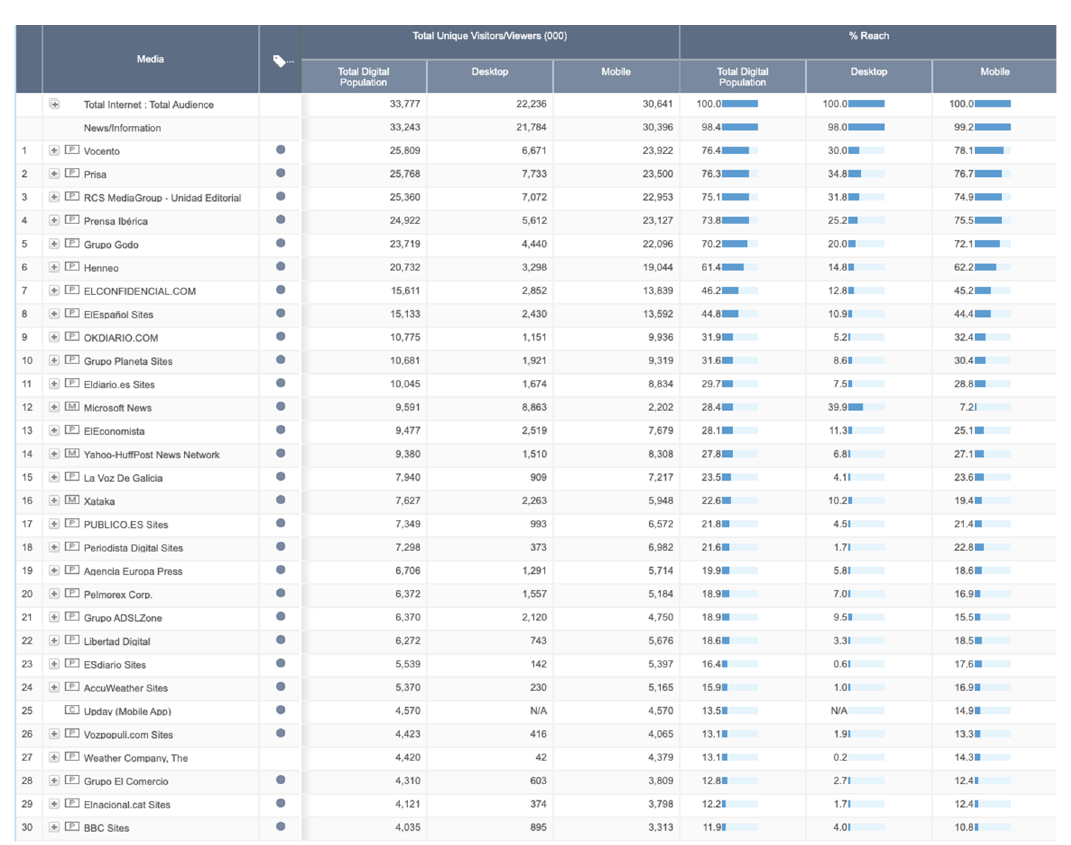
Figure 1. Ranking News ComScore Top 30 News, June 2019. Reference to establish the study population.